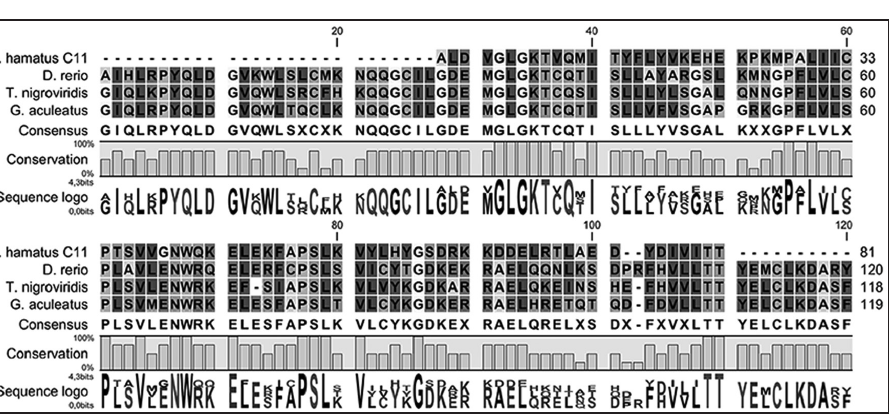
Figure 2. Alignment of the N-terminal portion of a Chromodomain-helicase-DNA-binding protein 1-like (CHD1) with the homologous CHD1 sequences of fish: Danio rerio , Tetraodon nigroviridis , and Gasterosteus aculeatus .